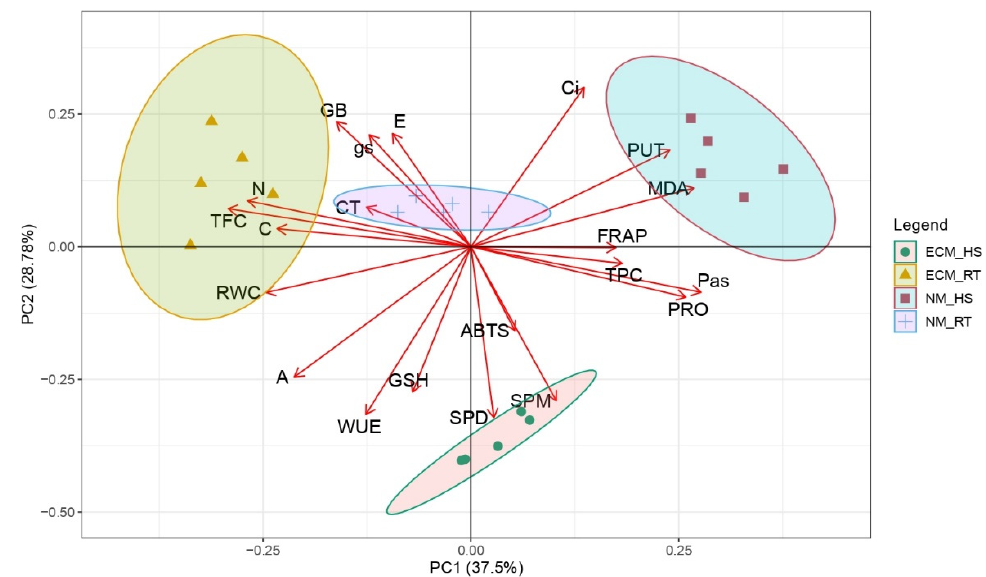
Figure 6. Loadings and the scores of examined treatments at the level of interaction for polyamines, compatible solutes, antioxidant capacities, and physiological parameters for Q. robur for the first two principal components. Treatments: RT—control oak seedlings grown at room temperature, HS—heat- stress-treated oak seedlings, ECM—oak seedlings inoculated with ectomycorrhiza inoculum, and NM—oak seedlings not inoculated with ectomycorrhiza inoculum.